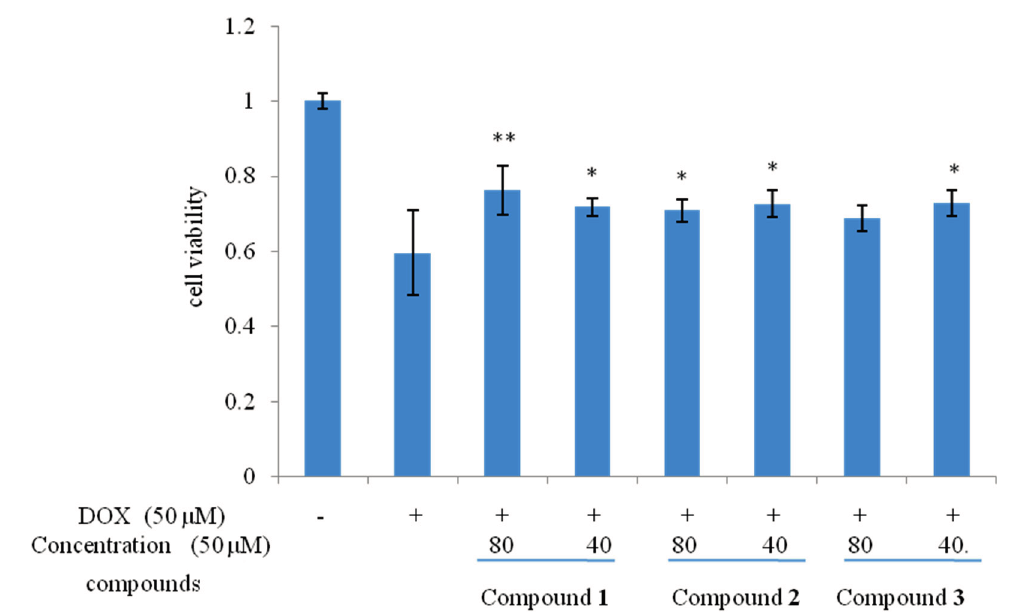
Figure 4. Protective effects of 1 – 3 on DOX-induced cytotoxicity in H9c2 cell. n = 3; * p < 0. 05; ** p < 0.01 compared with the DOX